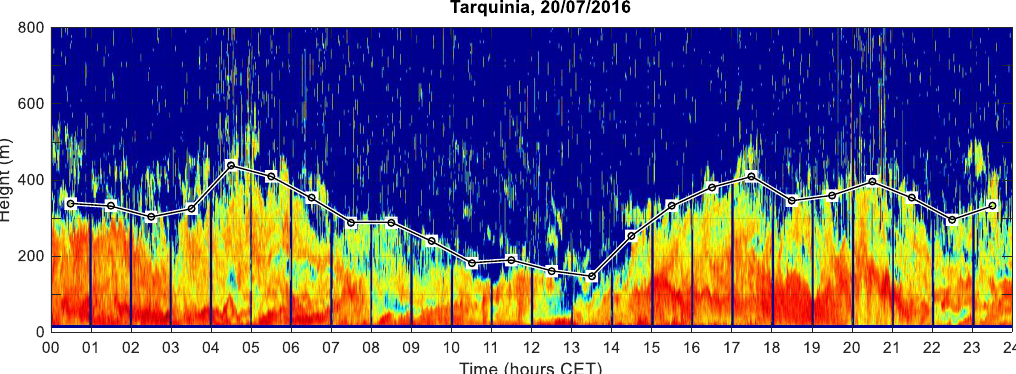
Figure 19. Example of the automatically estimated turbulent layer height (black circles) superimposed onto the sodar echogram for 20 July 2016.